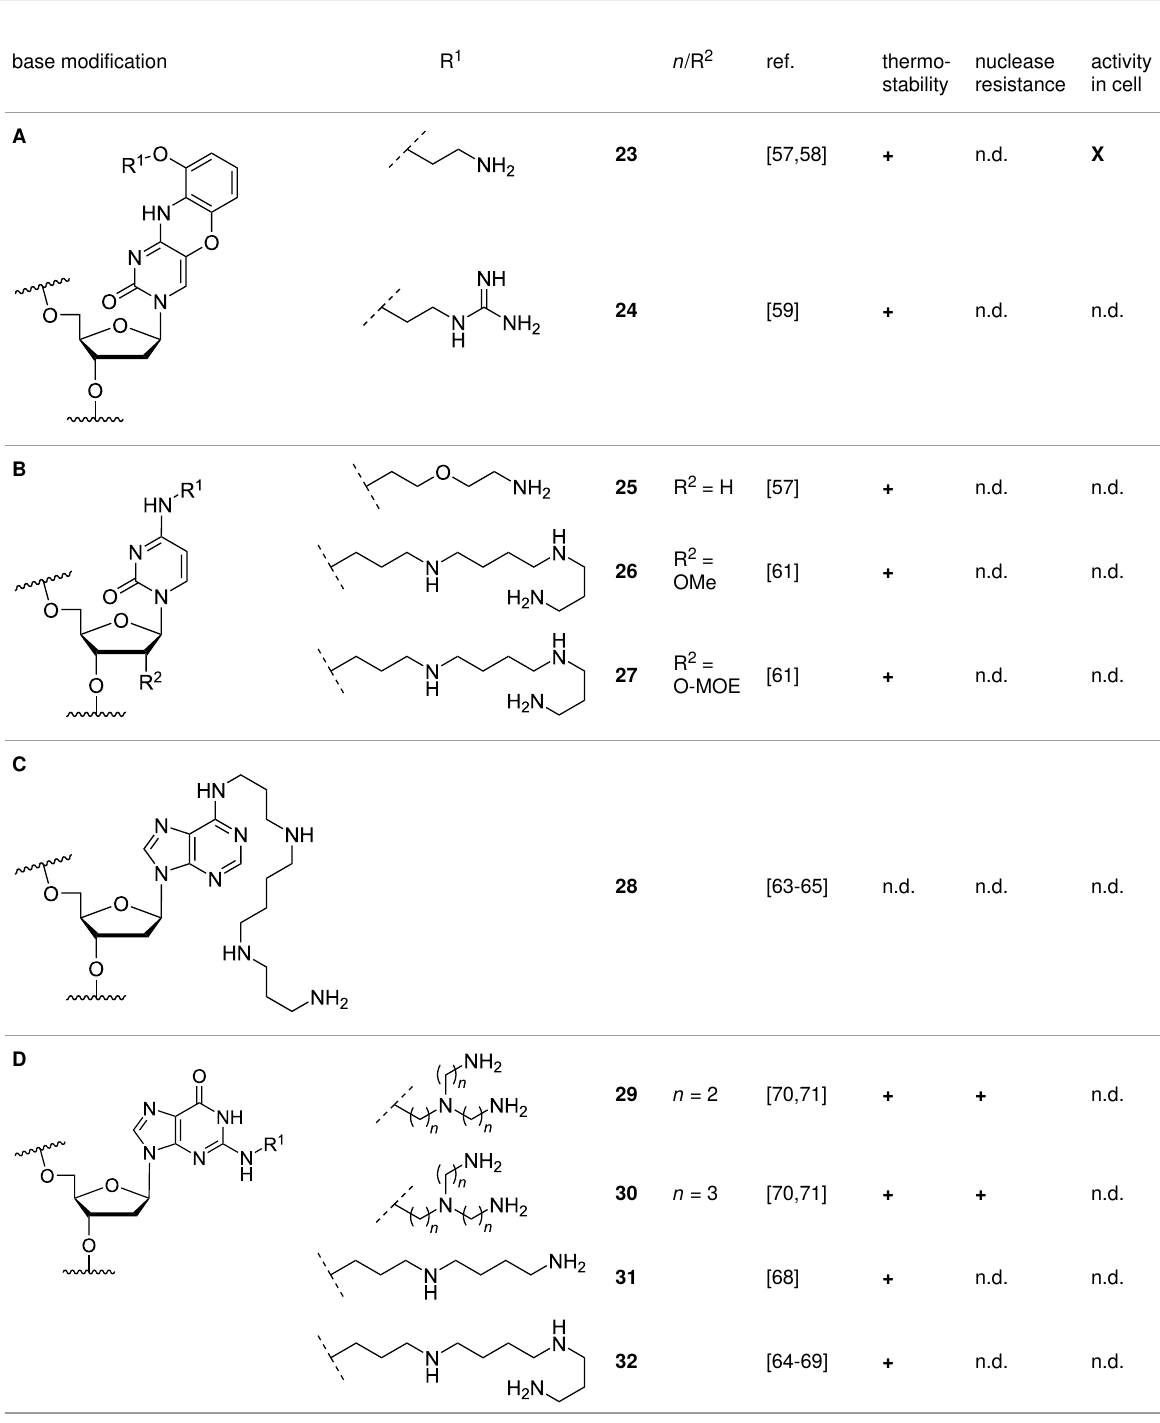
Table 3: Amine-functionalized groups on the nucleobase.